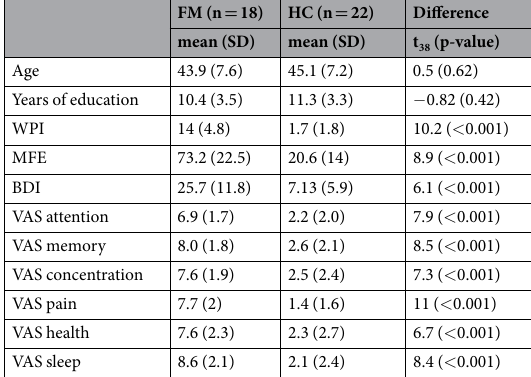
Table 1. Mean scores and statistical comparison of the psychosocial variables measured. Abbreviations: BDI - Beck Depression Inventory; WPI - Widespread Pain Index; MFE - Memory Failures of Everyday; VAS - Visual Analogue Scales measuring attentional, memory and concentration complaints, pain intensity, health status and quality of sleep in the last month (between 0 and 10, where 10 indicates the worst